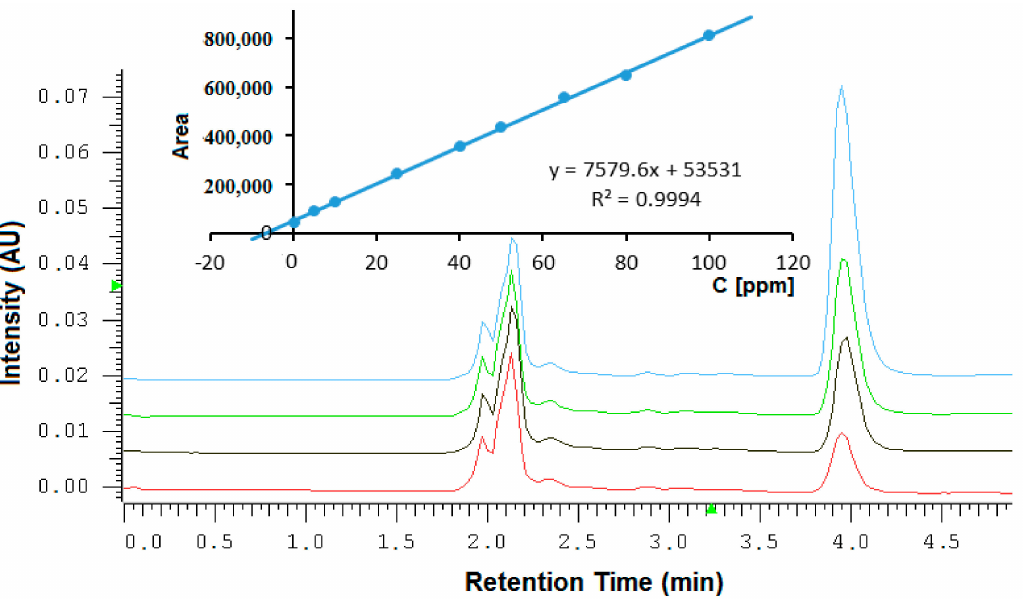
Figure 3. Chromatograms of saliva sample spiked in di ff erent standard concentrations (0 -red line, 5 mg L − 1 -black line, 10 mg L − 1 -green line, 25 mg L − 1 -blue line). Insert shows the regression line for